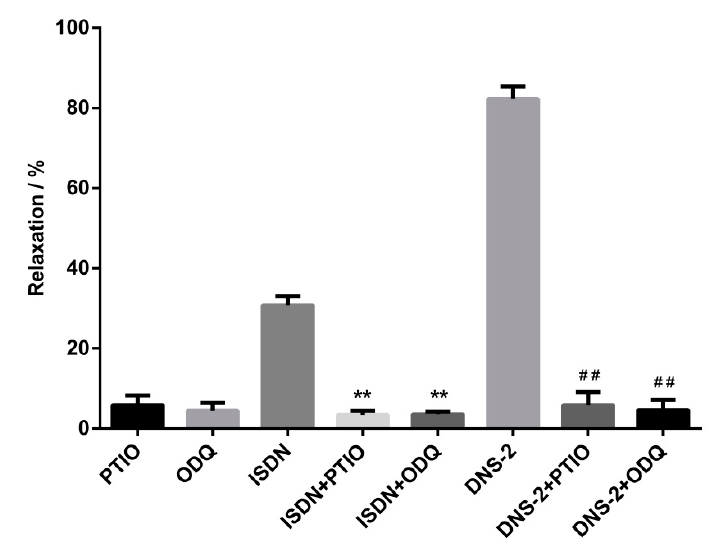
Figure 4. Inhibitory effects of DNS-2 (30 µ M) in the presence of PTIO (100 µ M) or ODQ (10 µ M) or PTIO (100 µ M) + ODQ (10 µ M) on the contractions induced by phenylephrine (1 µ M) in mesenteric artery rings. Data are expressed as the mean ± SD ( n = 3). ** p < 0.01 vs. ISDN, ## p < 0.01 vs. DNS-2.